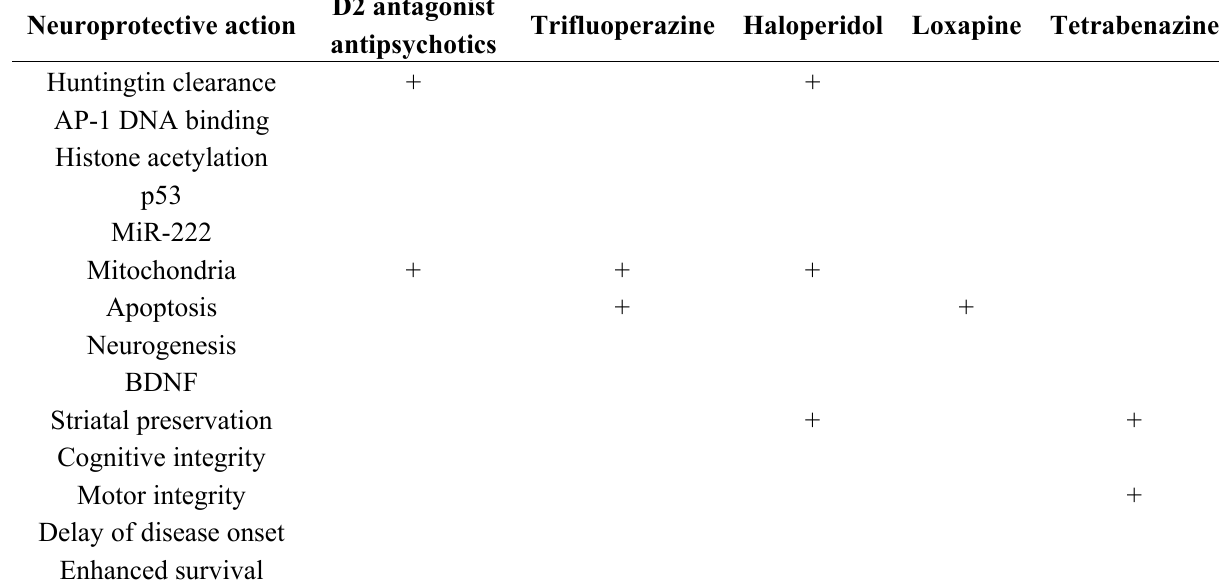
Table 5. Antipsychotic and tetrabenazine neuroprotective effects in Huntington’s disease